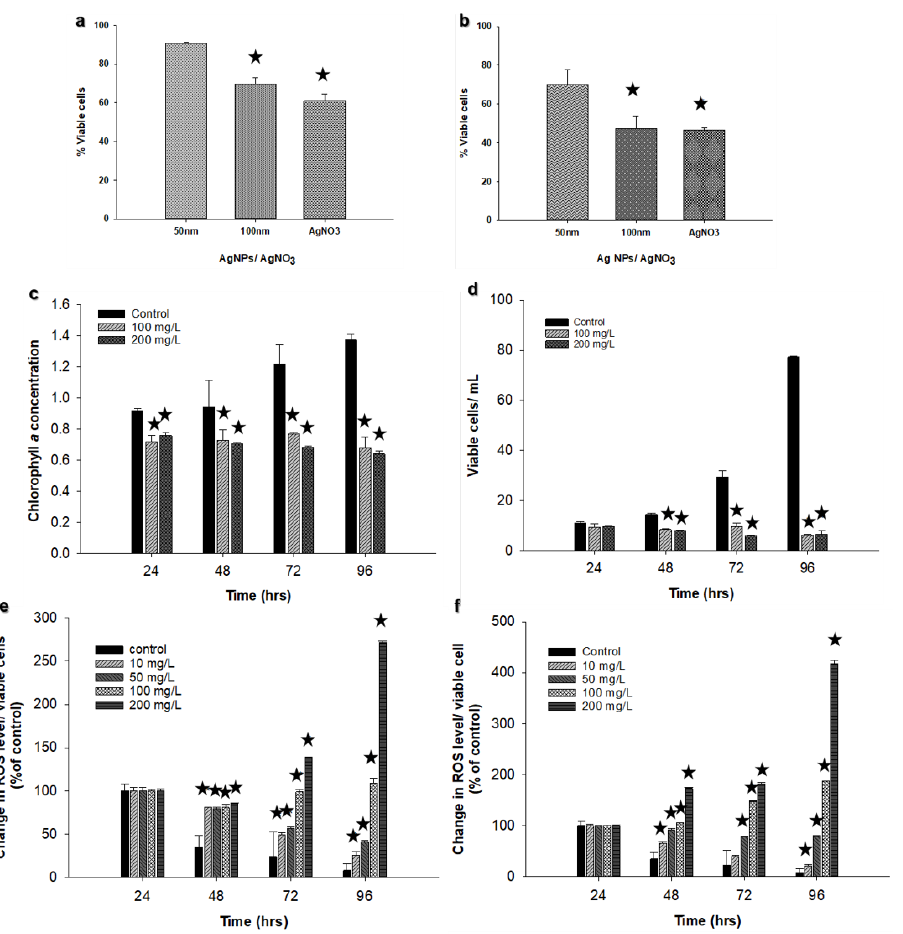
Figure 5. Comparison between Ag NPs and AgNO 3 at ( a ) 100 mg L −1 and ( b ) at 200 mg L −1 . Effect of AgNO 3 on chlorophyll a concentration in ( c ) µg L −1 , and ( d ) viable cells of Chlorella vulgaris. Changes in ROS in cells exposed to increasing concentrations of Ag NPs. ( e ) 50 nm Ag NPs; ( f ) 100 nm Ag NPs (Asterisks indicate significant differences from control values ( p < 0.05); n = 3).